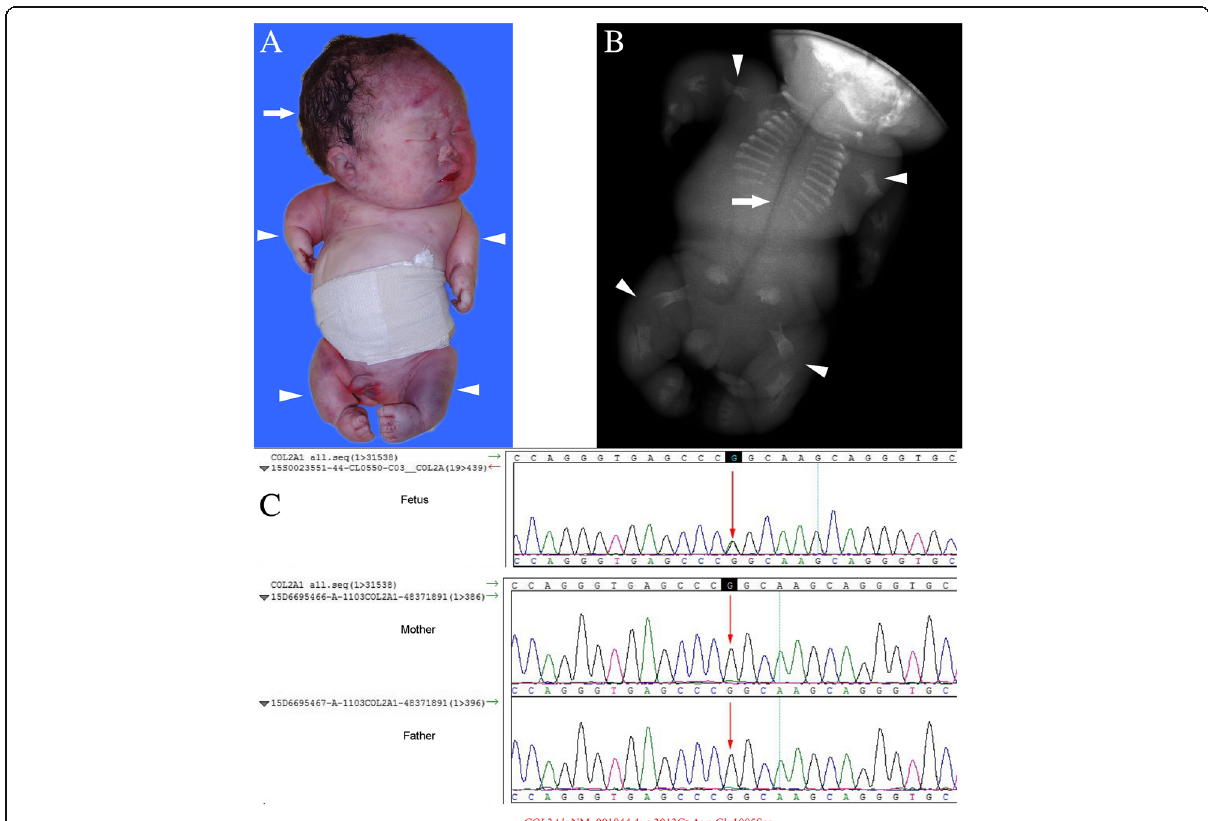
Fig. 3 Case 19: The fetus with achondrogenesis. a Gross anatomy of the aborted fetus, showing the markedly short arms and legs (arrowheads), with a giant skull (arrow). b X-ray images of the aborted fetus, showing the severe short limb (arrowheads), and the defective ossification of the spine, sciatic, pubic and iliac bone (arrow). c The fetus carried the c.3013G > A (p.Gly1005Ser) mutation in the COL2A1 gene. The Sanger verification revealed that this mutation was new, and was not carried by the